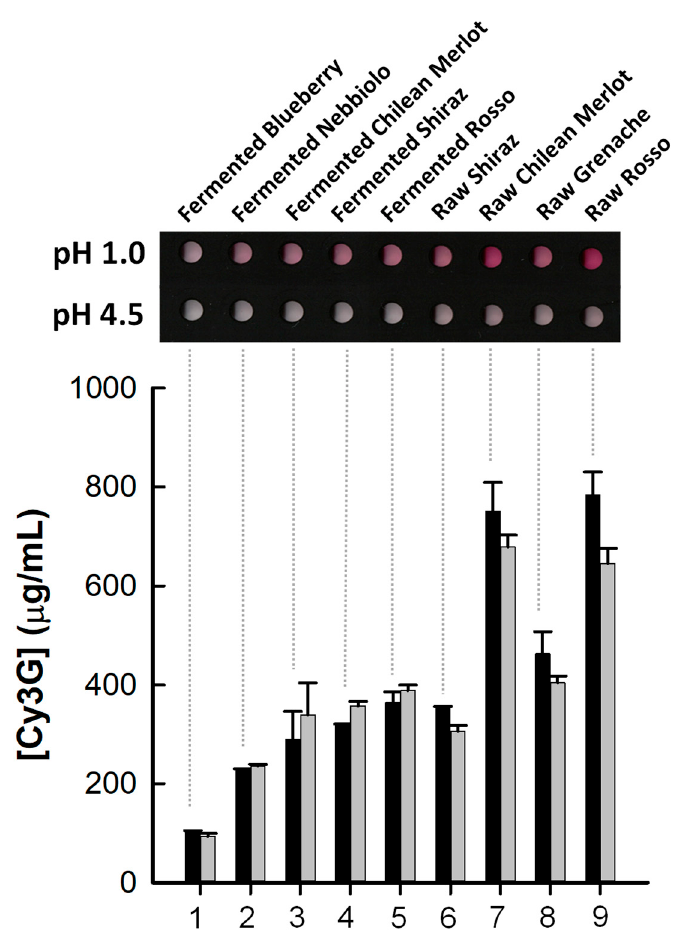
Figure 6. Comparison of the standard spectrophotometric (gray bars) and microchip (black bars) methods in the determination of total anthocyanins in fruit beverages. The top inset is the scanned photo of the PDMS chip employed for the analysis.